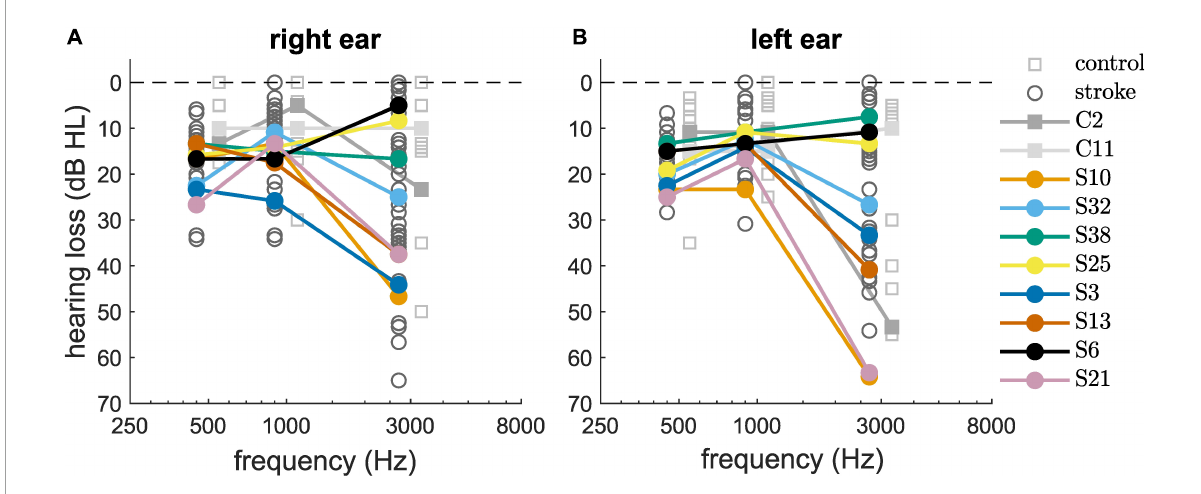
FIGURE1 Pure-tone audiometric thresholds of the control group (squares) and the stroke group (circles) measured at the right ear (A) and left ear (B) . Selected participants are highlighted by the color coding used throughout the figures.